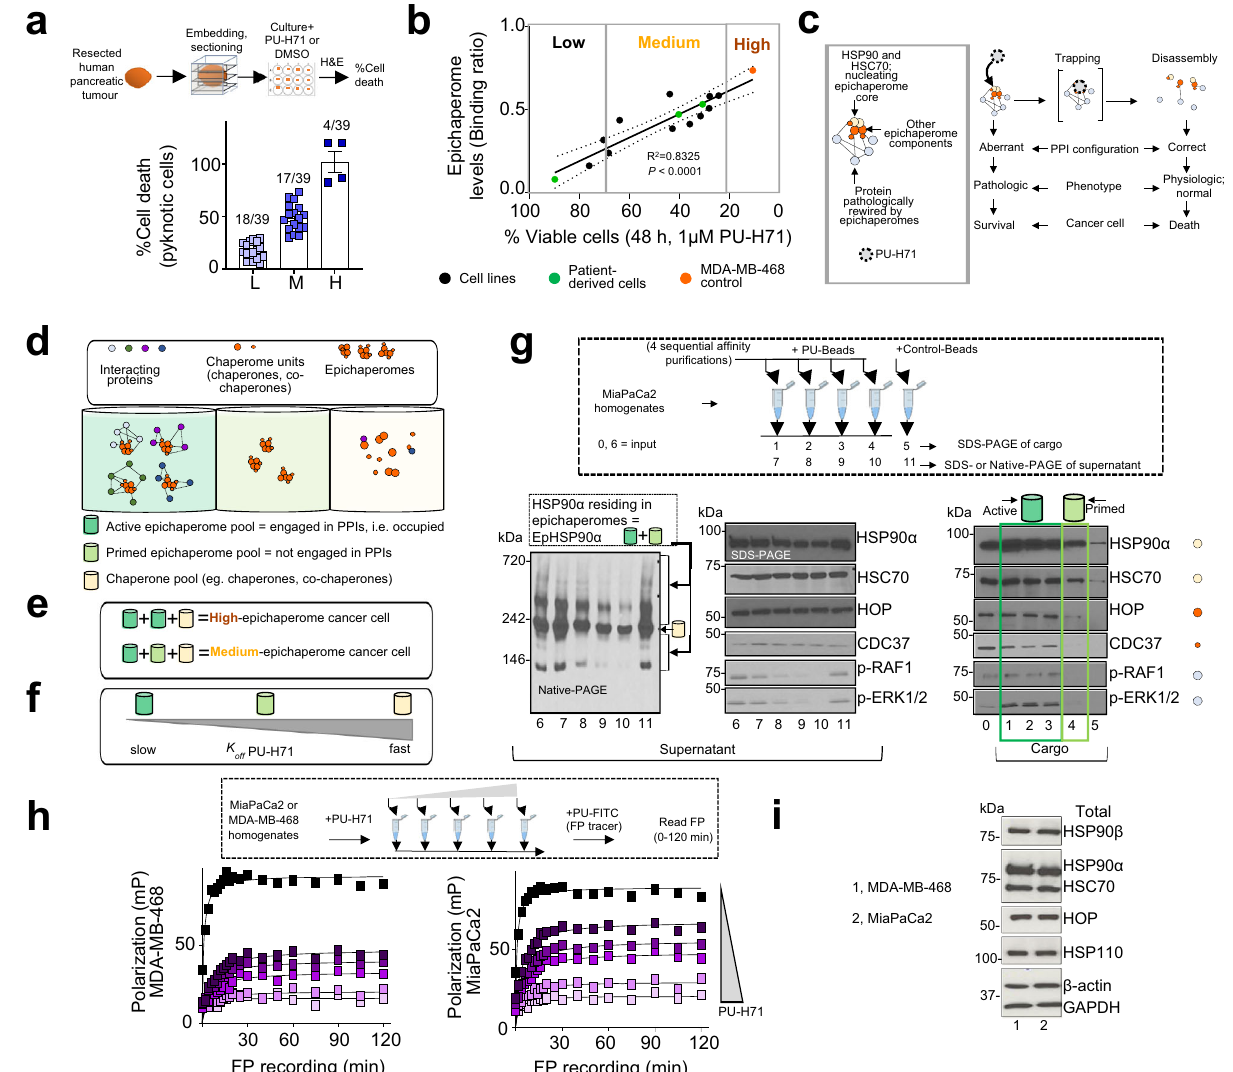
Fig. 1 Epichaperome occupancy is associated with sensitivity to PU-H71 in pancreatic cancer cells. a Viability of human pancreatic cancer surgical explants (n = 39) treated for 48 h with PU-H71 (1 µ M). Values were normalised to DMSO (vehicle) treated explants. Error bars represent SEM. L, low; M, medium, H, high. b Correlative analysis performed in pancreatic cancer cells between cytotoxicity (evaluated by Annexin V staining) and epichaperome levels (see Supplementary Fig. 1). MDA-MB-468 cell line, high-sensitivity, high-epichaperome control. Each data point is the mean of triplicate experiments. Pearson ’ s r, two-tailed, n = 14 cell types. c Schematic of the biochemical and functional effect of PU-H71 on cancer cells via epichaperome supression. Grey box, schematic of an epichaperome oligomer. d Schematic showing the heterogenous pools of chaperome assemblies in a cancer cell. e Composition of epichaperome pools in high- and medium-epichaperome cancer cells. f PU-H71 ’ s relative dissociation rate constant ( k off ) for the distinct chaperome assemblies. g Sequential af fi nity puri fi cation using a solid support immobilised PU-H71 (PU-beads). Representative gels of three experimental repeats are shown for cargo and supernatant. h Fluorescence polarisation (FP) analysis performed in MDA-MB-468 vs MiaPaCa2 cell lysates pre- incubated with increasing concentrations of PU-H71. Each curve represents the mean of three biological replicates, and the data is representative of three independent experiments. i Western blot analysis of chaperones that are key components in epichaperome formation. β -actin and GAPDH, protein loading controls. Representative gels of three experimental repeats are